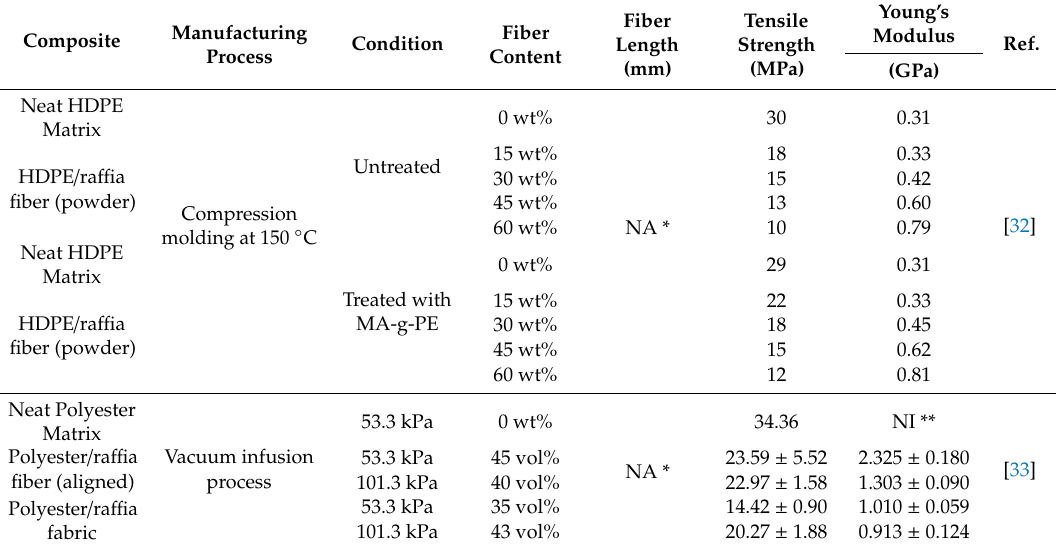
Table 1. Earlier results of tensile tests of Ra ffi a fiber composites